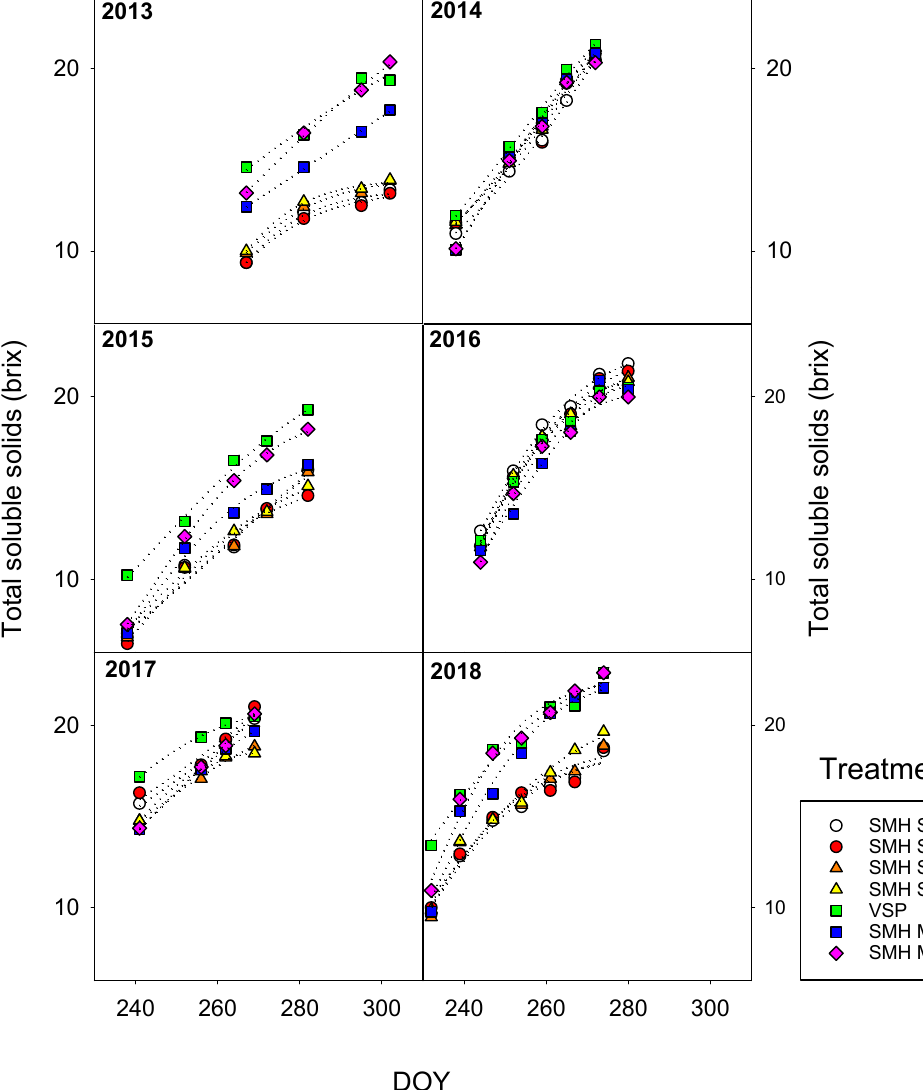
Figure 3. Progress of the total soluble solids in the different treatments between 2013 and 2018 as functions of the assessment date (DOY). Plot symbols represent the observed disease severities, with lines showing the calculated progress according to the sigmoidal equation type y = a /(1 + e − (( x − x 0 )/ b ) ). SMPH, semi-minimal pruned hedge; ST, shoot topping; VSP, vertical shoot positioning; MT, mechanical thinning.